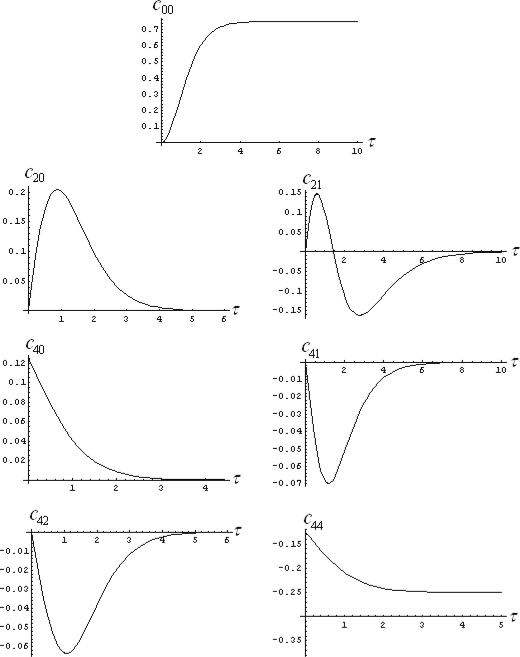
Temporal behavior of the coefficients (456) for the Fokker-Planck anharmonic conditioned probability density (455) for unitary drift and diffusion constants γ = D = 1 [48].